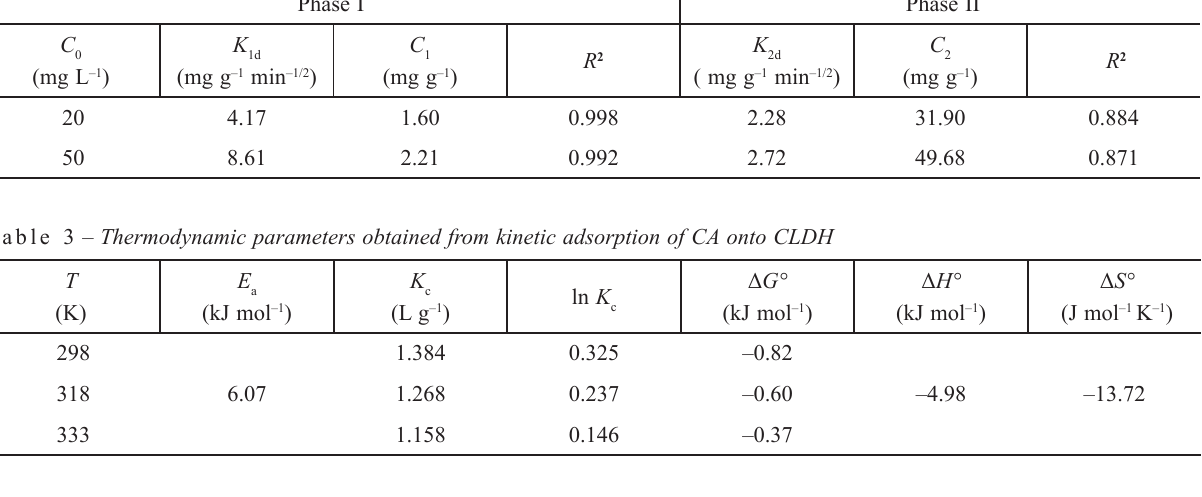
Table 2 – Parameters of intraparticle diffusion model for adsorption of CA by CLDH Phase I Phase II C 0